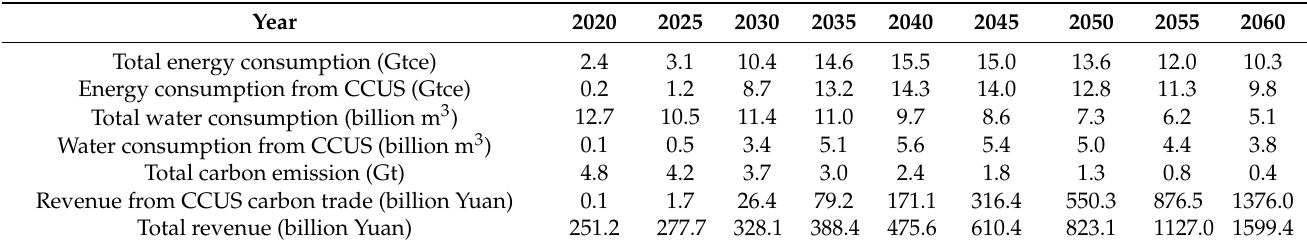
Table 17. ATPCC Output of baseline portfolio for China’s coal power industry.